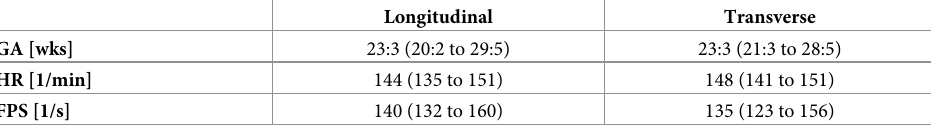
Table 1. General and echocardiographic characteristics of the study population.